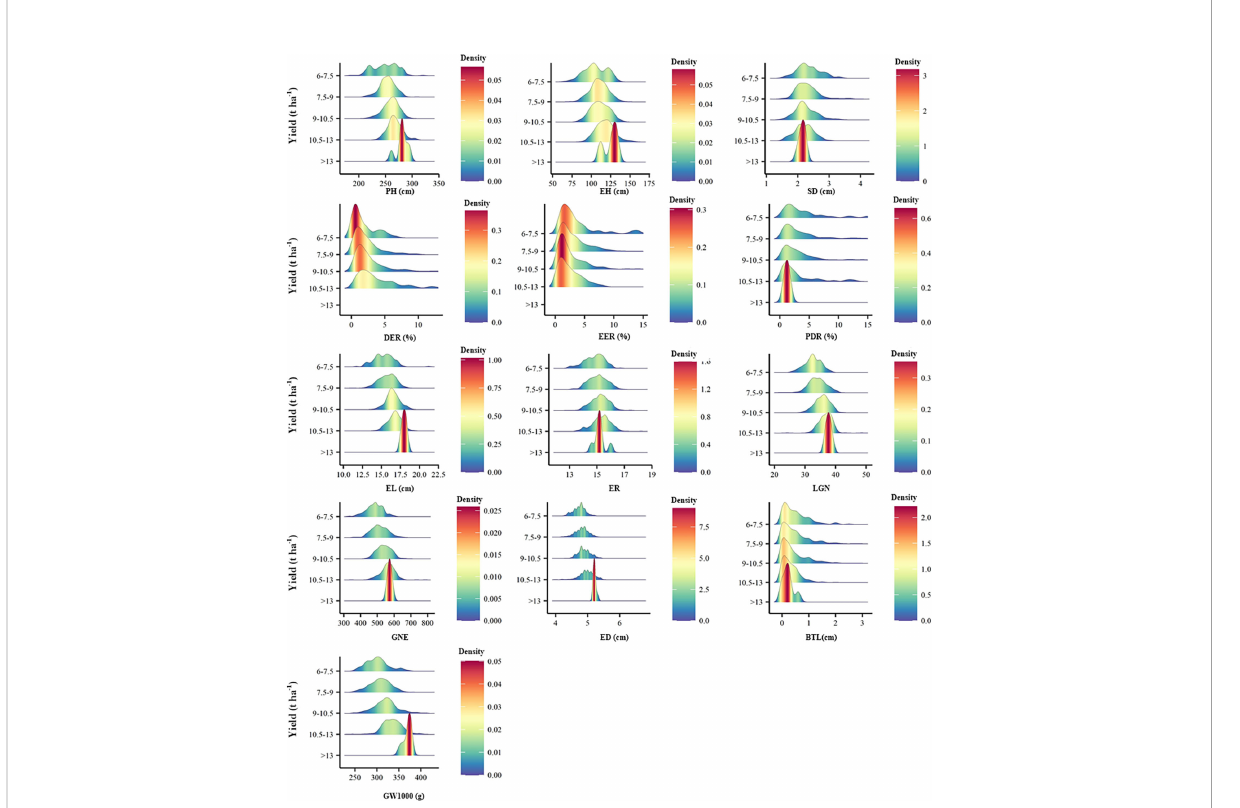
FIGURE 6 Peak map of distribution of agronomic traits of different yield levels. PH, plant height, cm; EH, ear height, cm; SD, stem diameter, cm; DER, Double ear rate, %; EER, empty ear rate, %; PDR, Pour the discount rate, %; EL, ear length, cm; ER, ear rows; LGN, Line grain number; GNE, grain number per ear; ED, ear diameter, cm; BTL, bald tip long, cm; GW1000, 1000 grains weight,